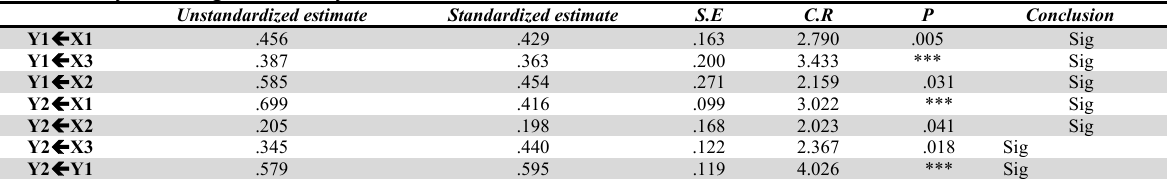
The summary of the regression analysis Unstandardized estimate Standardized